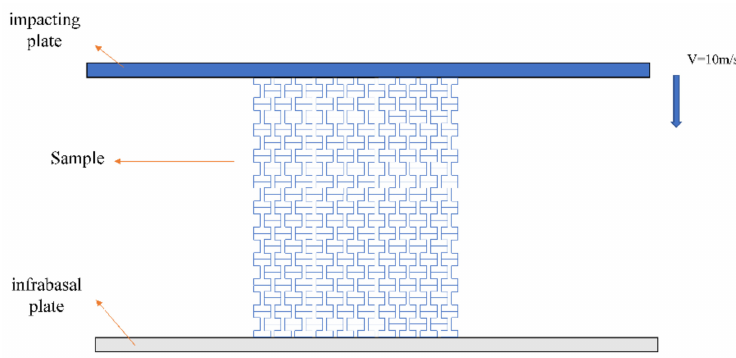
Figure 8. Impact on negative Poisson’s ratio honeycomb core